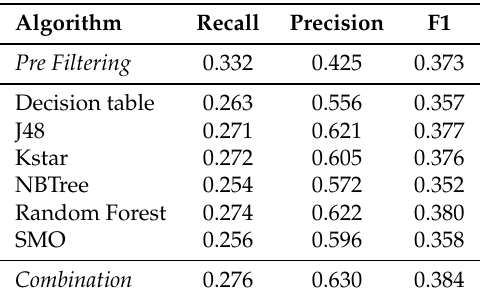
Table 12. Performance using the TAC KBP 2013 Slot Filling scorer on the test dataset when using alternatively different algorithms to filter responses for every relation (Relation